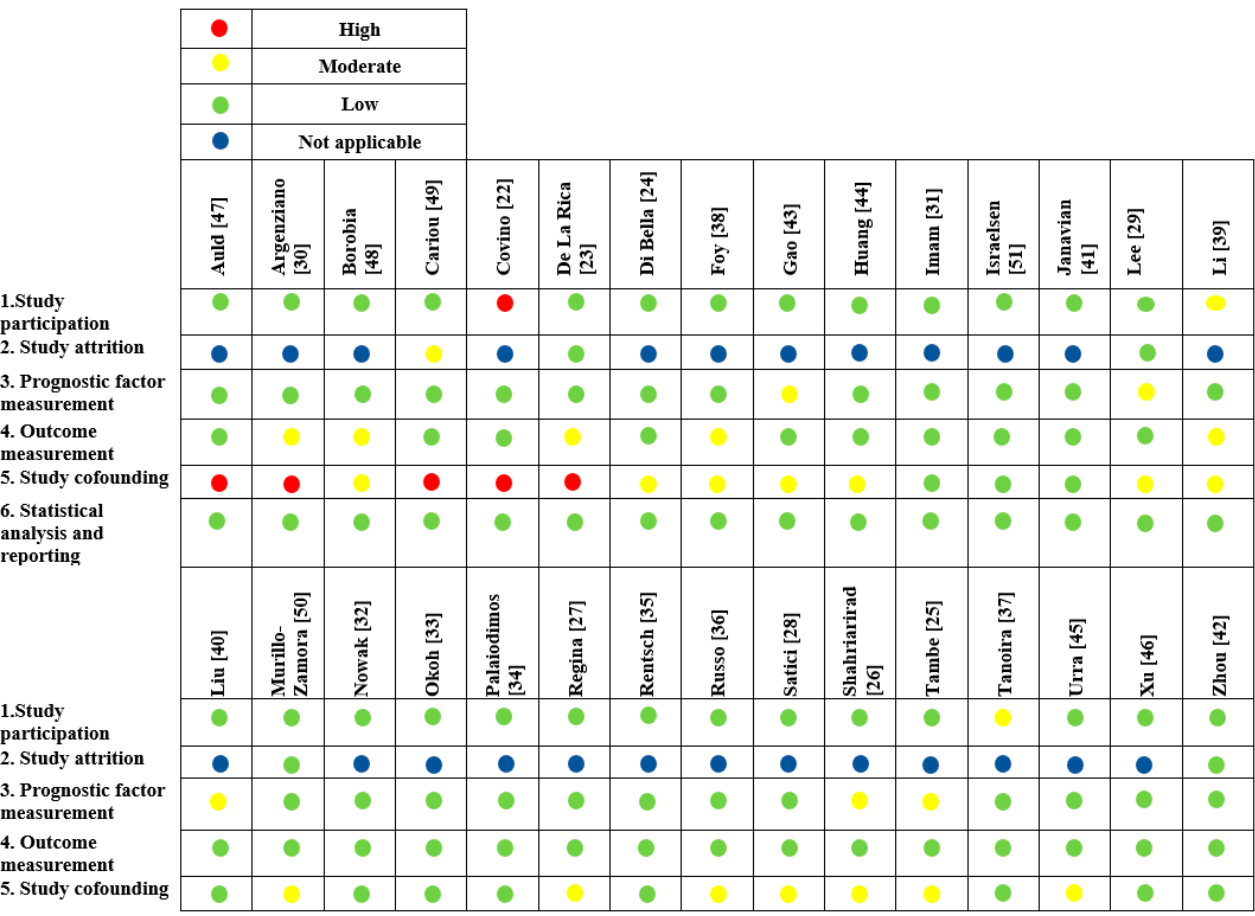
Figure 2. Quality in Prognosis Studies—QUIPS Tool: Risk of Bias Assessment.